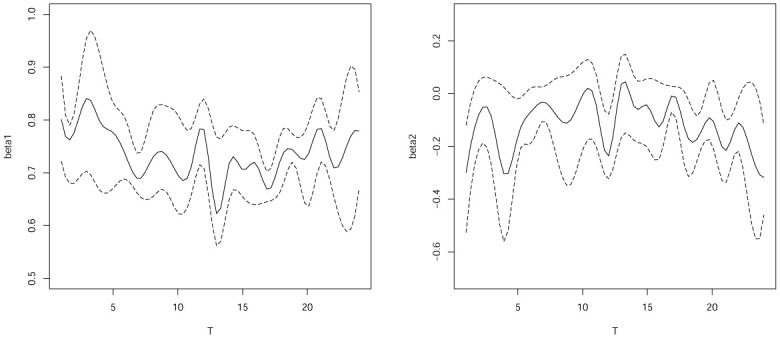
Estimates and the corresponding pointwise confidence interval of β1(t), β2(t) for complete data.